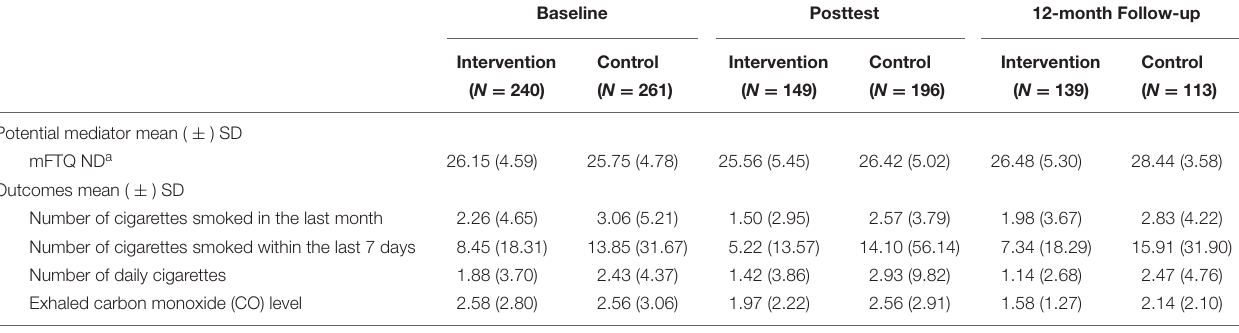
TABLE 3 | Self-report of tobacco consumption measures, and ND (as mediator) by condition and assessment period. Baseline Posttest